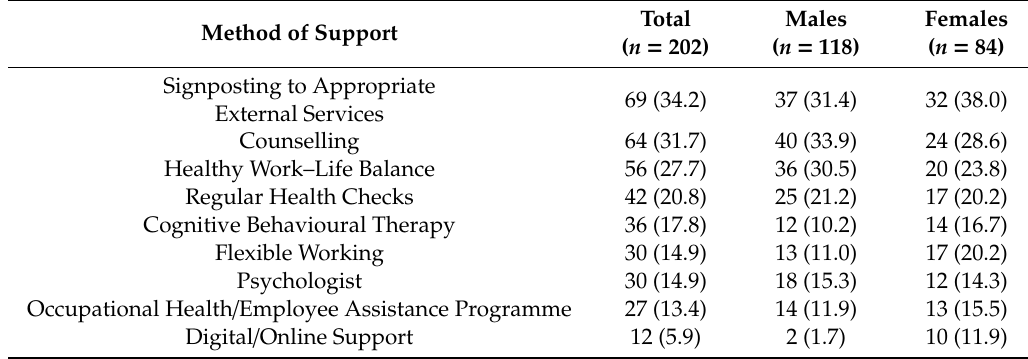
Table 5. Type of mental health support coaches would like from their organisation ( n and %).